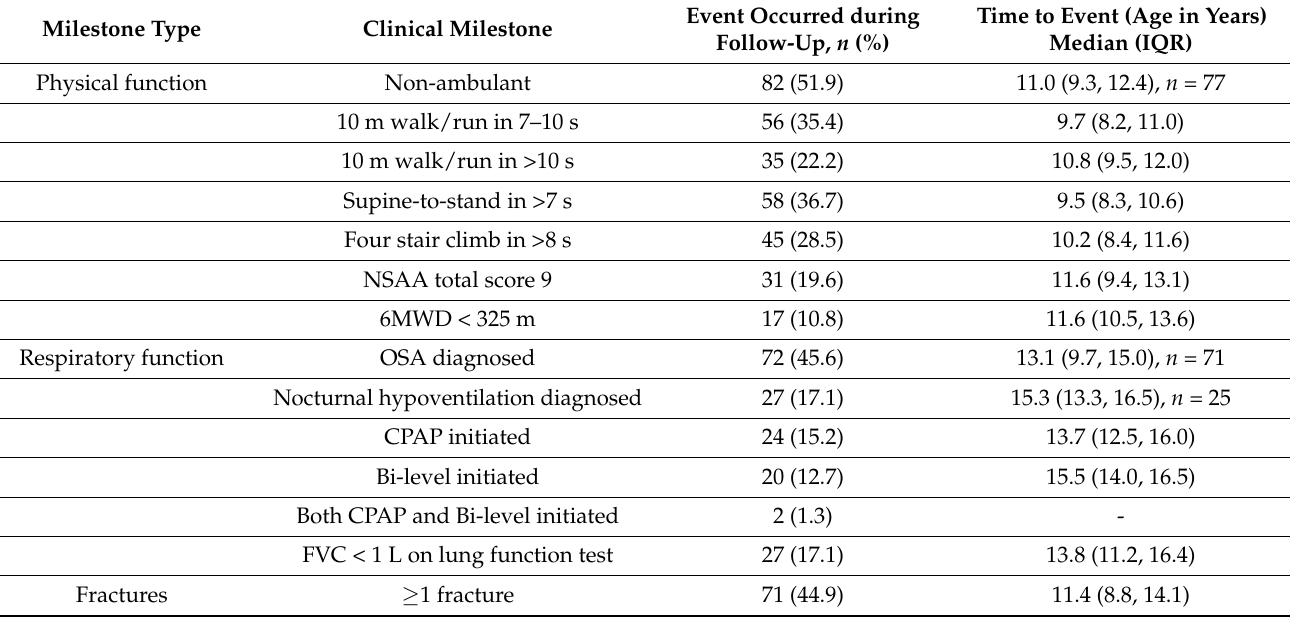
Table 3. Descriptive Data for Clinical Milestones 1